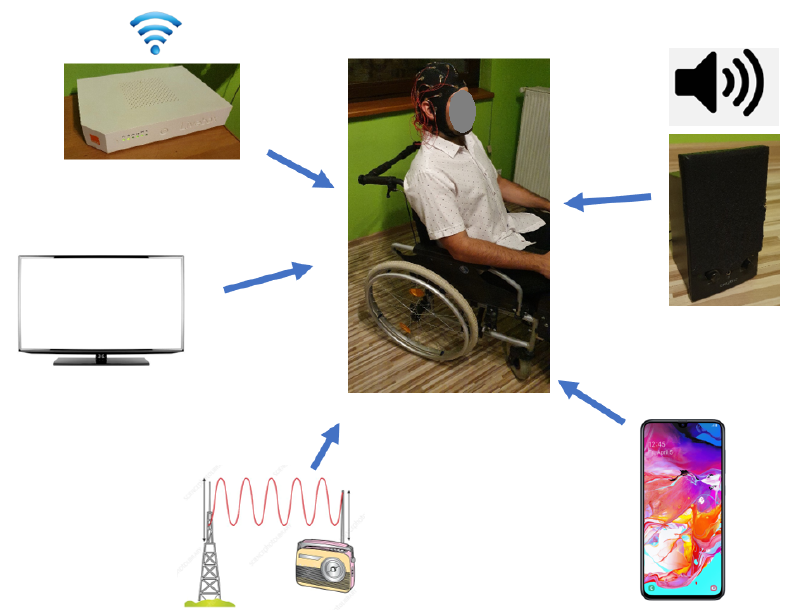
Figure 2. Presentation of disturbances occurring during